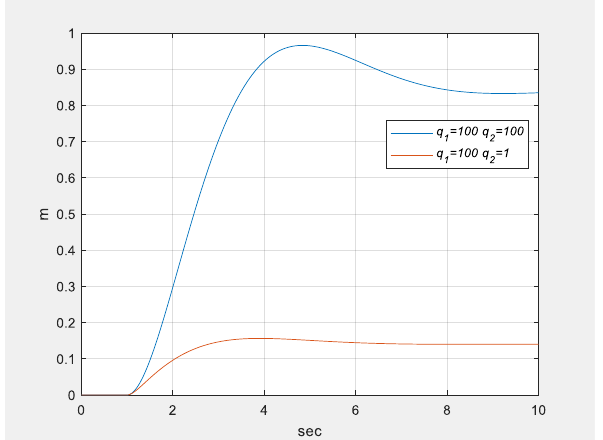
.  and the  and the θ s and the s  and the s s